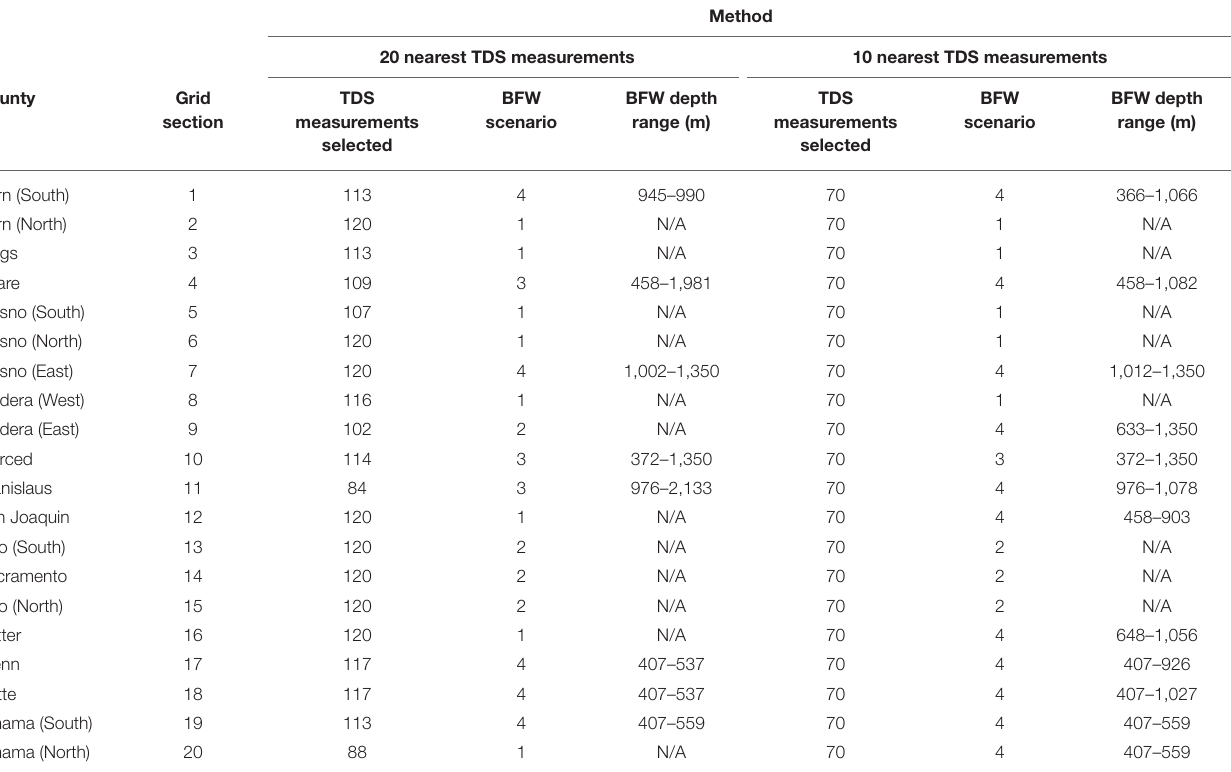
TABLE 2 | Number of selected TDS measurements and ability to determine BFW for each of the 20 selected grid sections using methods that select the nearest 20 and 10 TDS measurements to the center of each grid